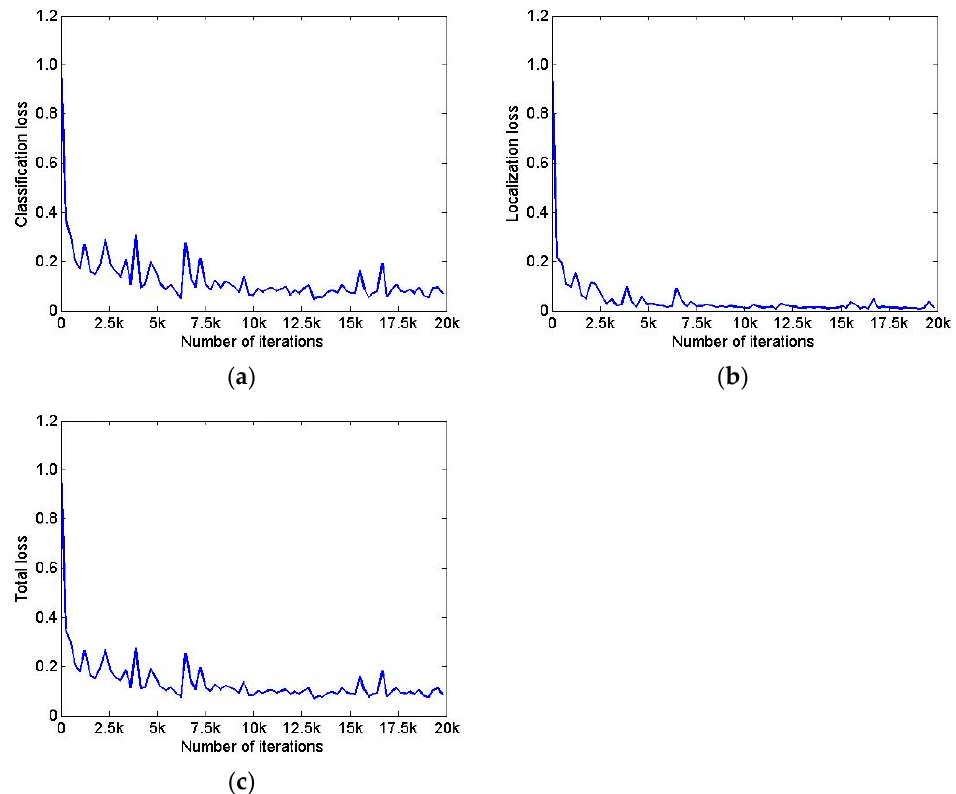
Figure 14. Changing diagram of each loss during model training. ( a ) Changing process of classifica- tion loss. ( b ) Changing process of location loss. ( c ) Changing process of total loss. After training, a model is generated that can be called. Through the generated model, the location of the sampling area of the field image can be detected, and a prediction frame can be generated.